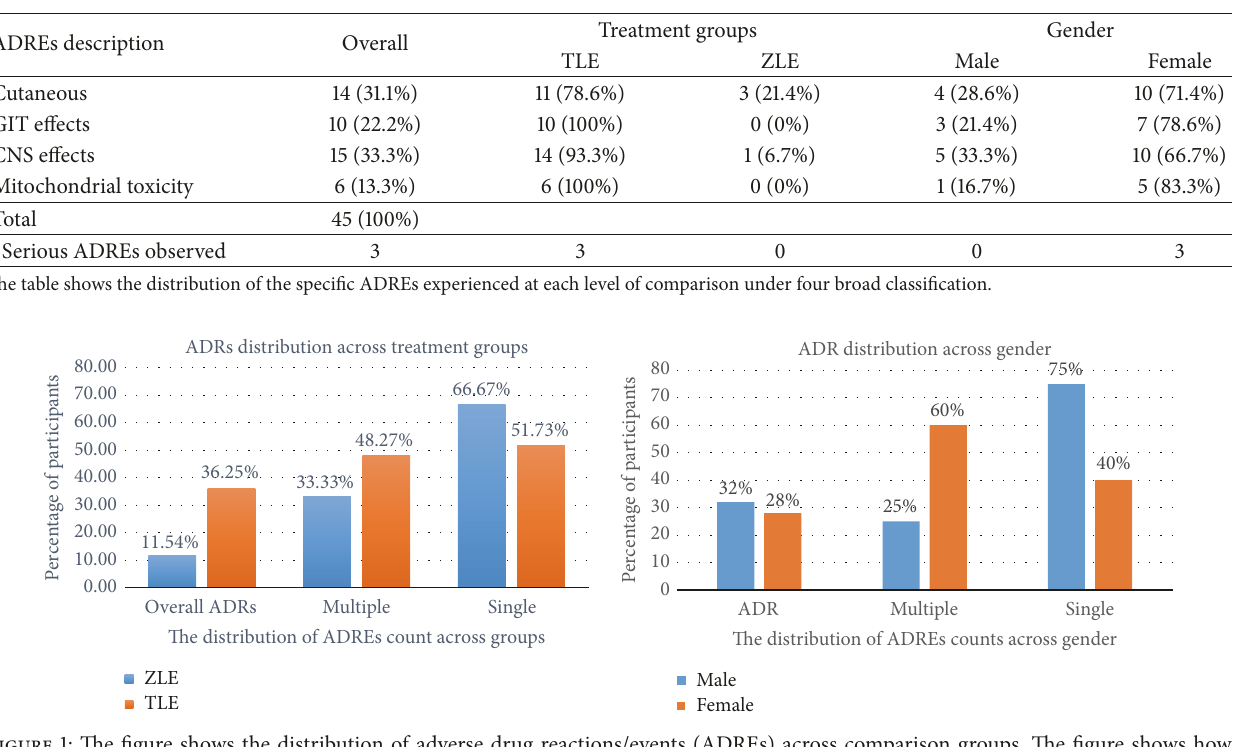
Table 3: Classification/distribution of ADREs in the treatment groups and gender.